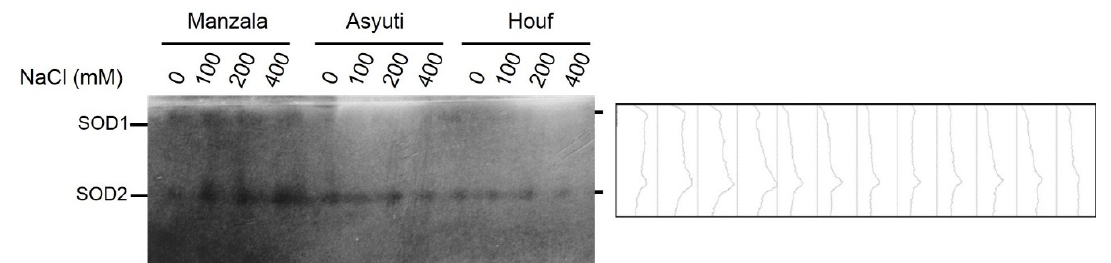
Figure 12. Superoxide dismutase activity of Z. coccineum plants after 45 days incubation under 0, 100, 200 and 400 mM NaCl.